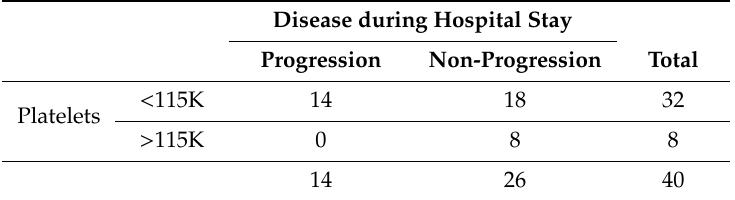
Table 4. 2 × 2 contingency table for progression to moderate / severe Hantavirus cardiopulmonary syndrome (HCPS) of Andes orthohantavirus (ANDV) mild disease cases at admission versus a platelet count threshold of 115 K / mm 3 at admission.